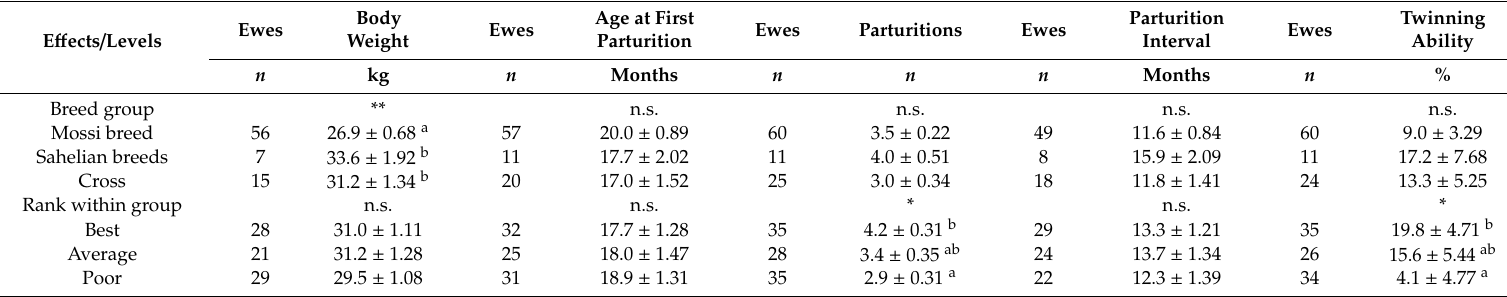
Table 9. Least-square means (LSM) ± standard error (SE) for body weight and reproduction traits of ewes 1 owned by sheep breeders in Ouagadougou ( n = 31). E ff ects /